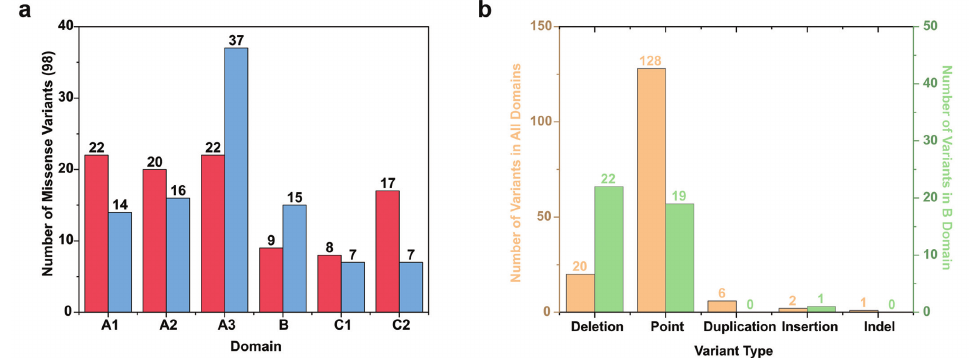
Fig. 5 Distribution of FV de fi ciency variants in the six FV domains . ( a ) The number of missense variants in each of the six FV domains is shown above the red bars. If the number of 98 missense variants are normalized in proportion to amino acid residues present in the sequence of each domain, the outcome is shown as blue bars. The two missense variants that occur in the linker region and the signal peptide are not shown. ( b ) The distribution of 42 variants in the B domain ( green ) is compared against the fi ve types of 157 genetic variants that occur in FV ( orange ). FV, Factor